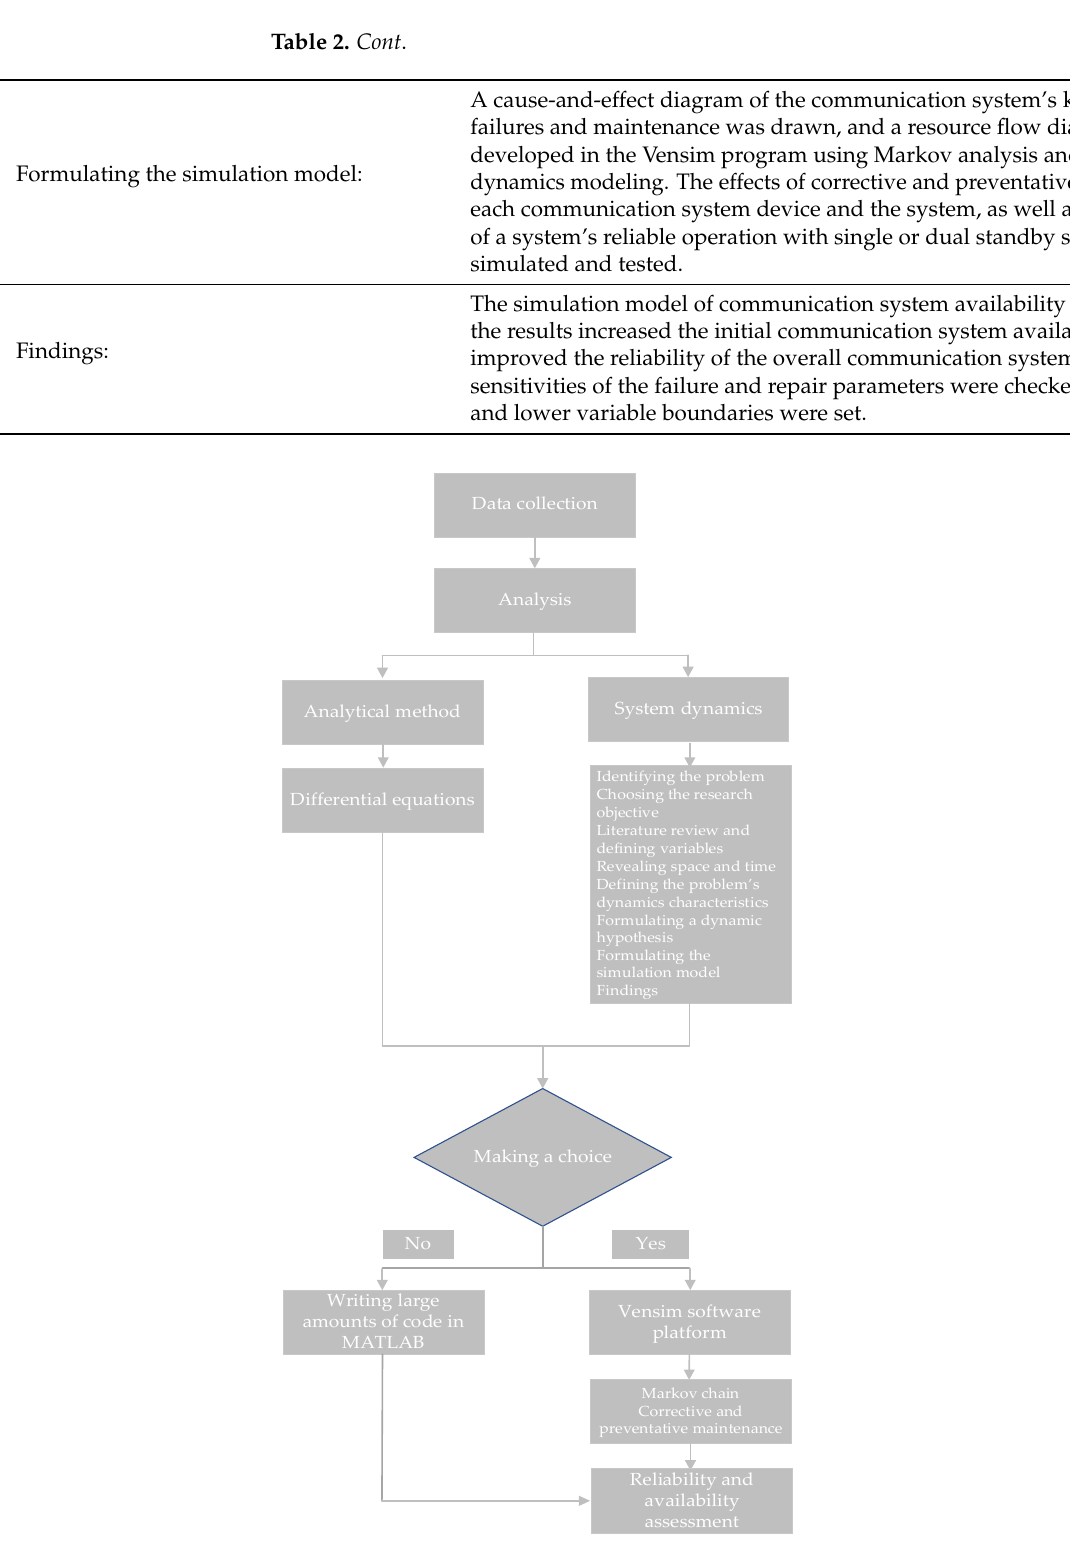
Figure 4. Schematic diagram of research methodology.